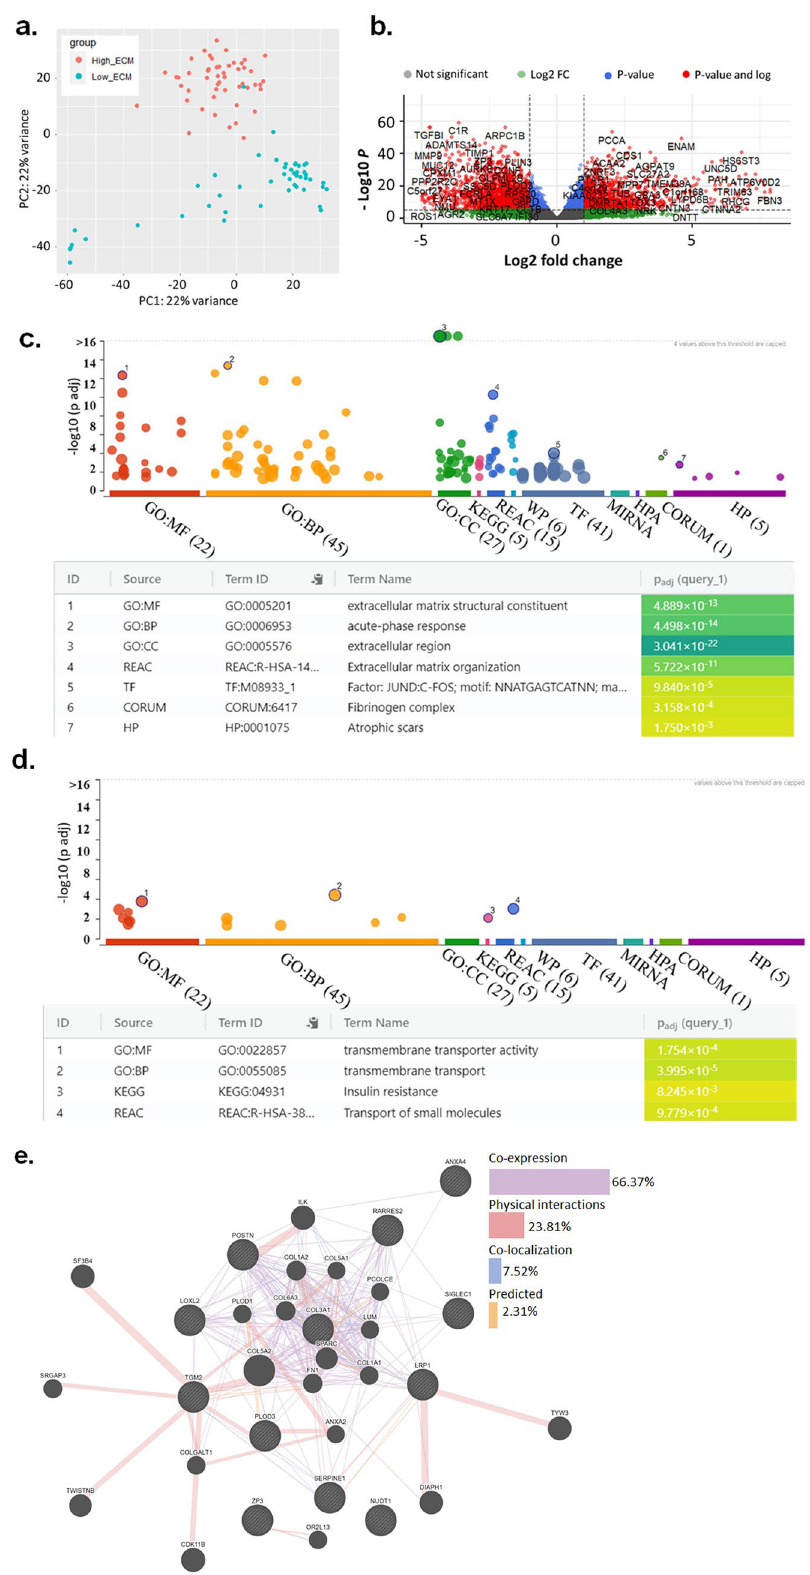
Figure 6. ( a ) Principal component analysis (PCA) showing distinct clustering between RNA-seq expression of high CDI patients (topmost 50 patients) compared to low CDI patients (bottom 50 patients). ( b ) Volcano plot showing differential expression of genes between High CDI and low CDI ( p < 0.01, log2 fold-change > 2). ( c ) Functional enrichment analysis of highly expressed genes (log2 fold-change > 2) in ( c ). High ECM group with most hits for extracellular matrix and ( d ) Low ECM group with maximum hits for transmembrane transport activity. ( e ) GeneMANIA gene–gene interaction network showed multiple connections, pre-dominantly co-expression and physical interaction among genes in prognostic